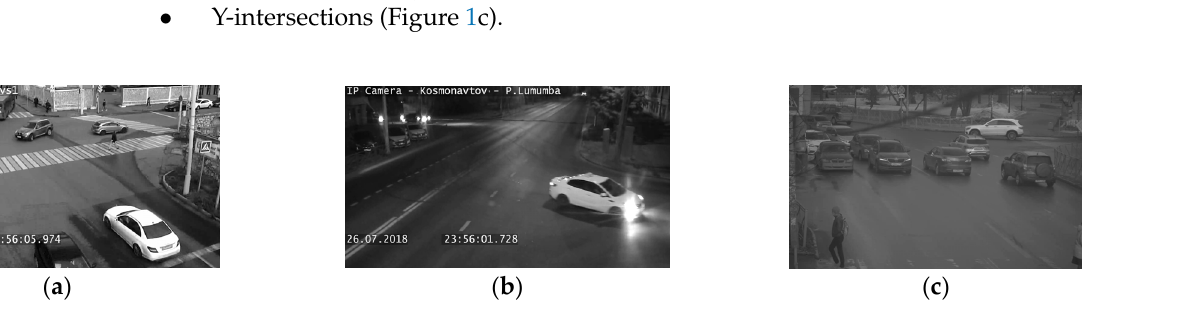
Figure 1. Road intersection types. Four-way intersections ( a ). T-intersections ( b ). Y-intersections ( c